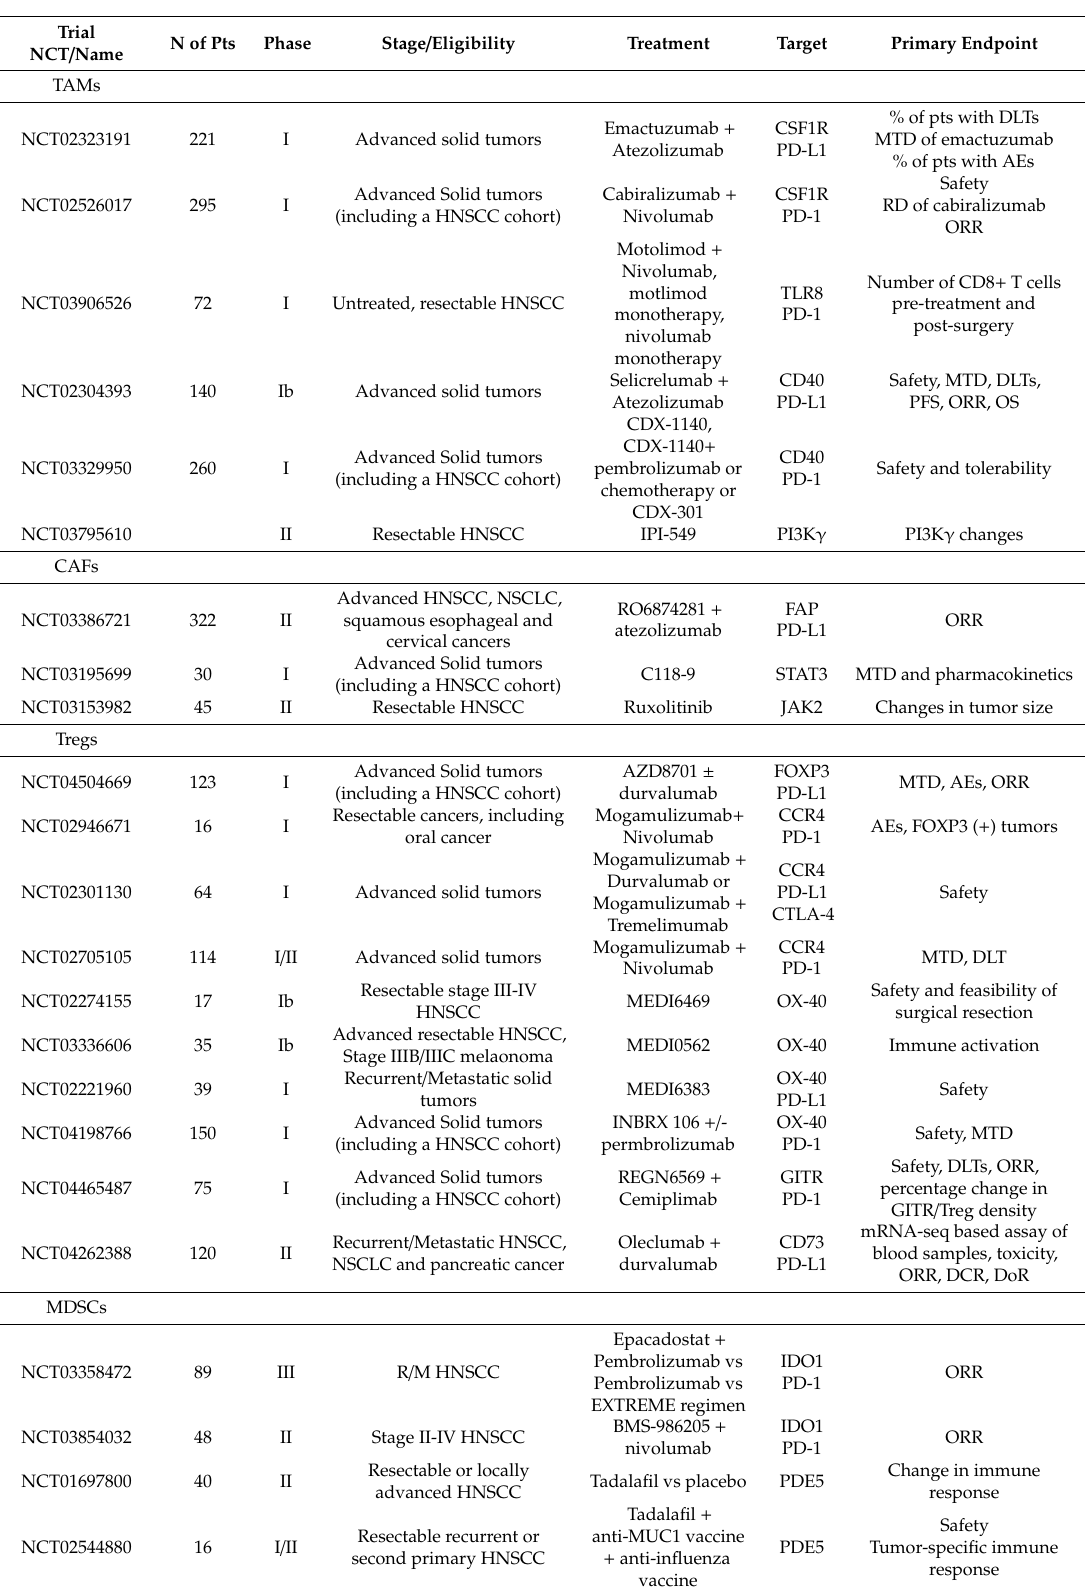
Table 1. Ongoing clinical trials targeting the TME ± immunotherapy in